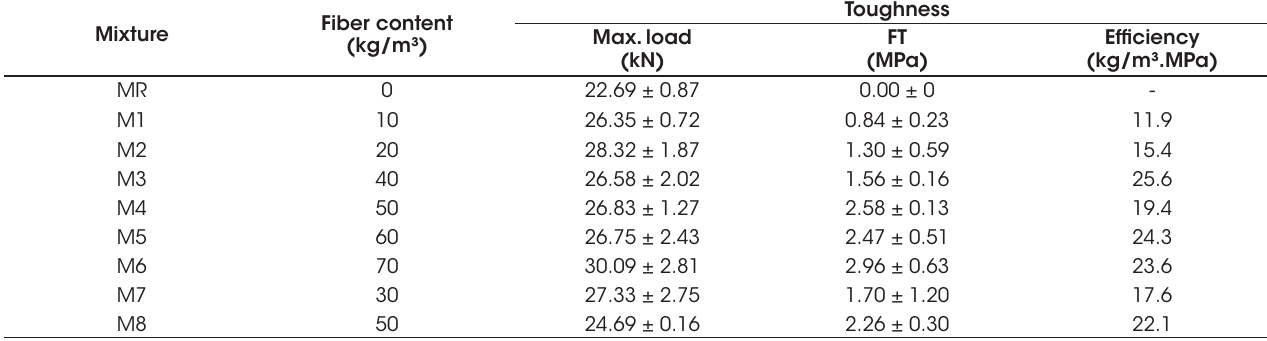
Average toughness values